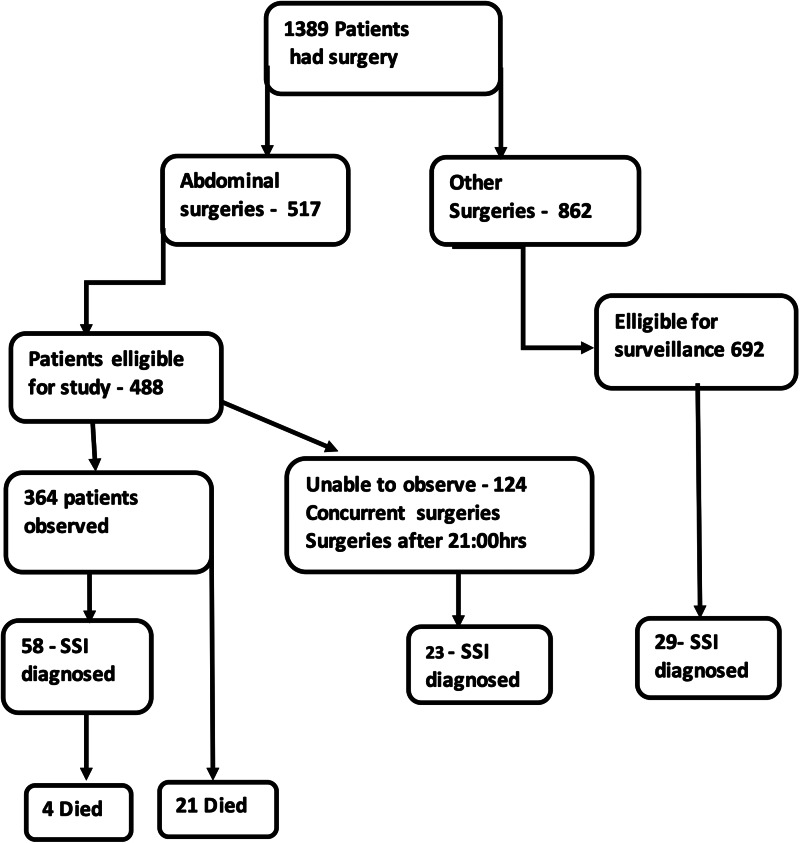
Flow chart of patients undergoing surgery in the general surgery unit of the teaching hospital showing the number undergoing abdominal surgeries or other surgeries – the number of abdominal surgeries eligible for the study and the actual number involved in the study to describe the risk factors of SSI.